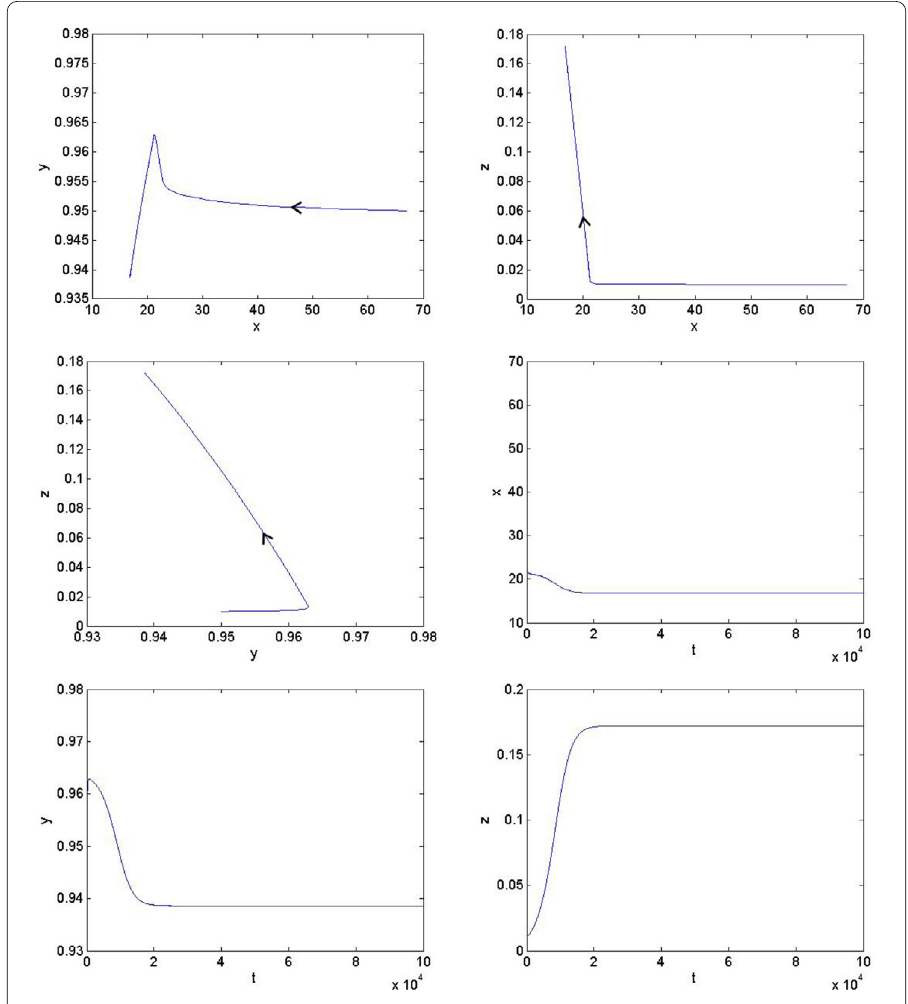
Figure 8 A computer simulation of the system of Eqs. (4)–(6) with c 1 = 0.9 day –1 , c 2 = 0.95 day –1 , c 3 = 0.239 day –1 , c 4 = 0.8 day –1 , c 5 = 0.445 day –1 , k 1 = 68, k 2 = 0.02, k 3 = 0.54, h 1 = 0.024, h 2 = 0.063, e 1 = 0.0001 day –1 , e 2 = 0.95 day –1 , e 3 = 0.98 day –1 , γ 1 = 0.01 day –1 , γ 2 = 0.062 day –1 , (cid:8) = 0.004 and δ =